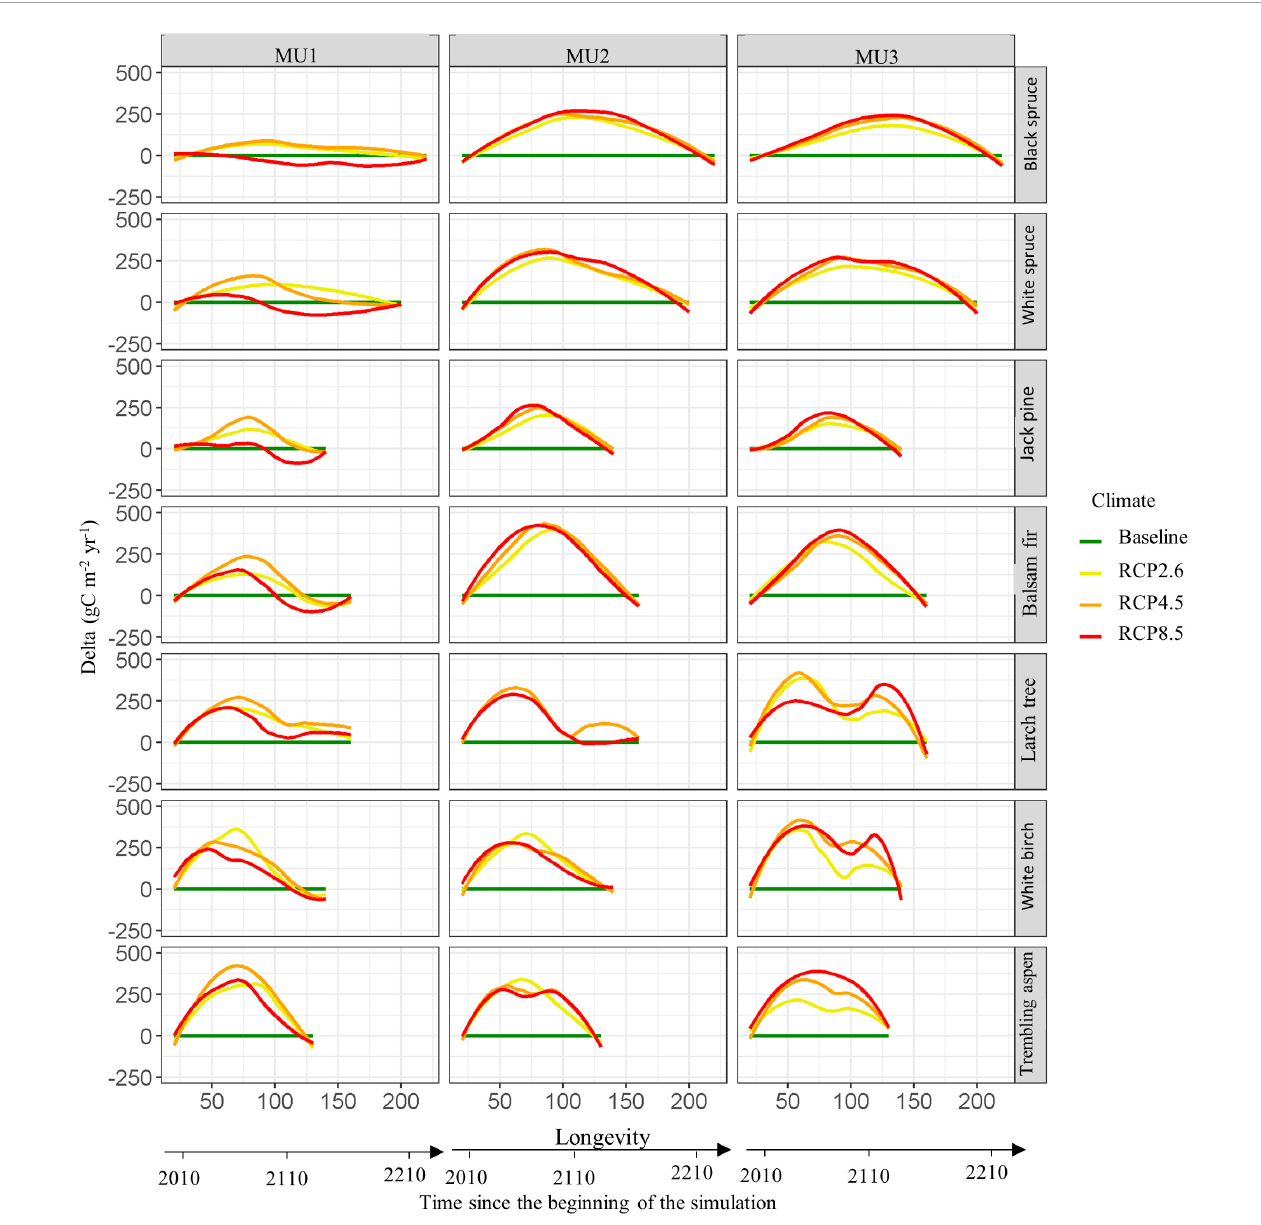
FIGURE5 The difference in species’ annual NPP (delta) between climate change scenarios and current climate (baseline) during their longevity age in the three management units (see Supplementary Figure 3 for more details about the NPP per species and its confident interval). The simulations were started in 2010 with a single cohort (20 years old, monoculture) using the dominant soil texture per management unit (clay in MU1, and sandy-loam texture in MU2 and MU3). During the simulations the growing season was increased under climate change effect from 90–120 to 150–180 days (see Supplementary Figure 4